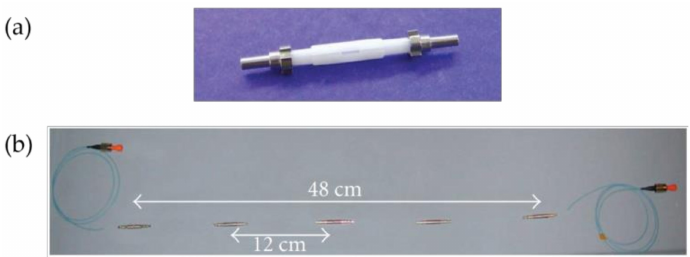
Figure 9. ( a ) Fiber section connector. ( b ) Multi-section sensing head containing 4 sections of photonic crystal fibers (PCF) [19].